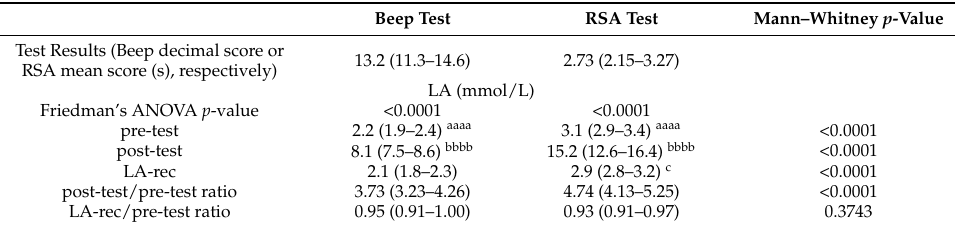
Table 3. The results of the tests performed by the participants and the level of lactic acid.